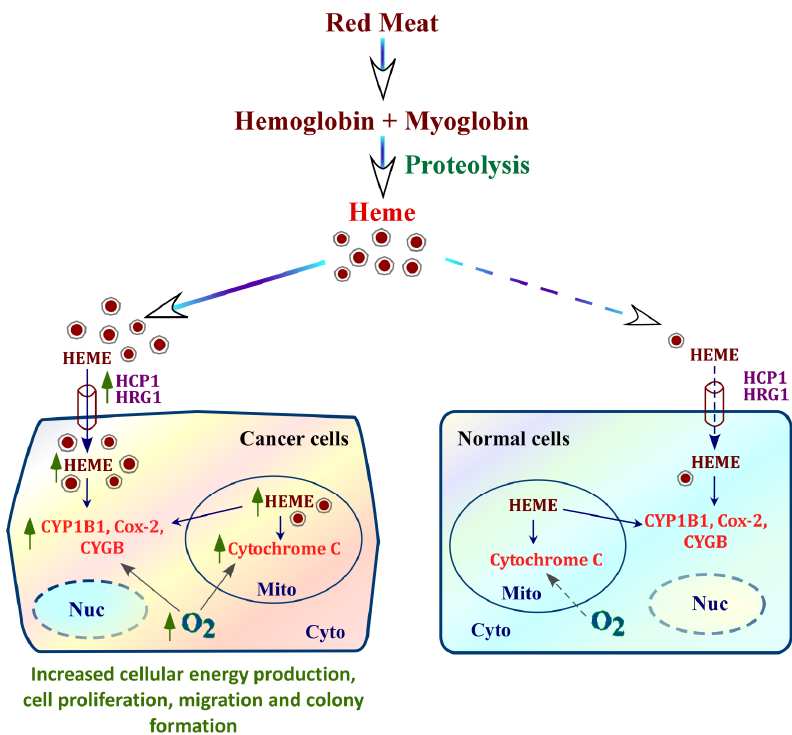
Figure 2. A cartoon illustrating a putative mechanism by which heme fuels cancer cell progression. Heme from blood can be taken up by cells via heme transporters HCP1 and HRG-1. Cancer cells have intensified internal heme synthesis as well as increased heme uptake via heme transporters, whose expression is dramatically elevated in cancer cells, compared to normal cells. As a result, the levels of an array of hemoproteins involving oxygen transport and utilization, such as cytoglobin and cytochrome c, are strongly enhanced. Enhanced levels of hemoproteins lead to intensified oxygen consumption and cellular energy generation, which in turn fuel cancer cell proliferation and